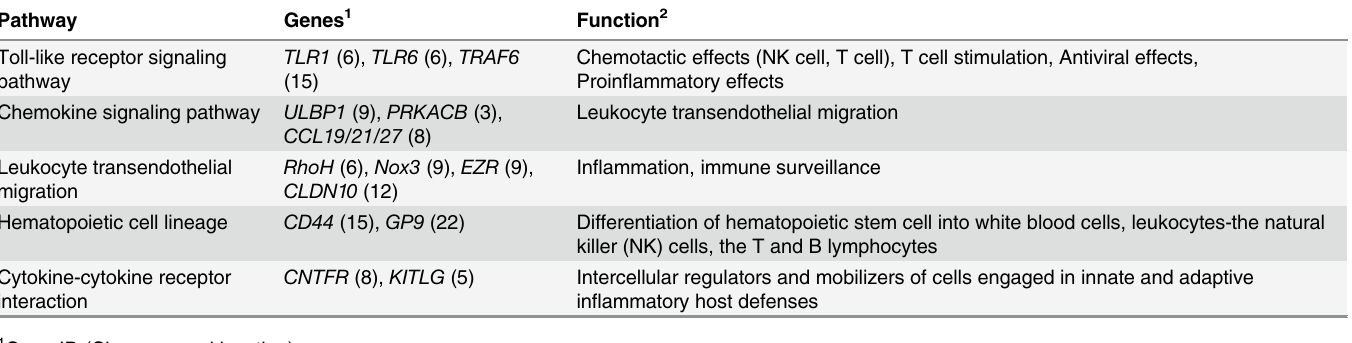
Table 2. Positional candidate genes related to immunological pathways.